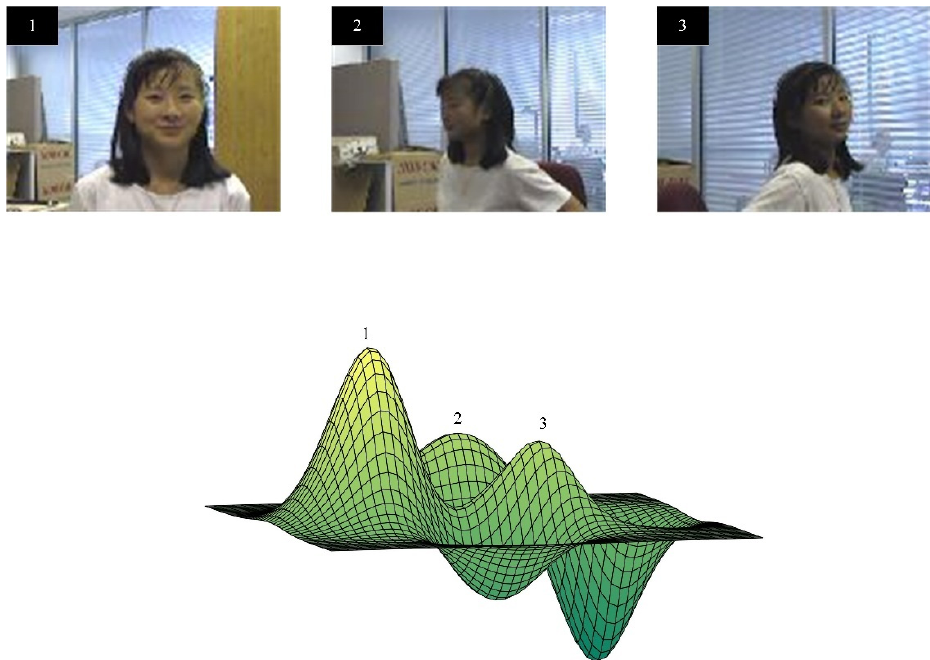
Figure 3. Different frames of the same target in a continuous image sequence correspond to different points on the Grassman